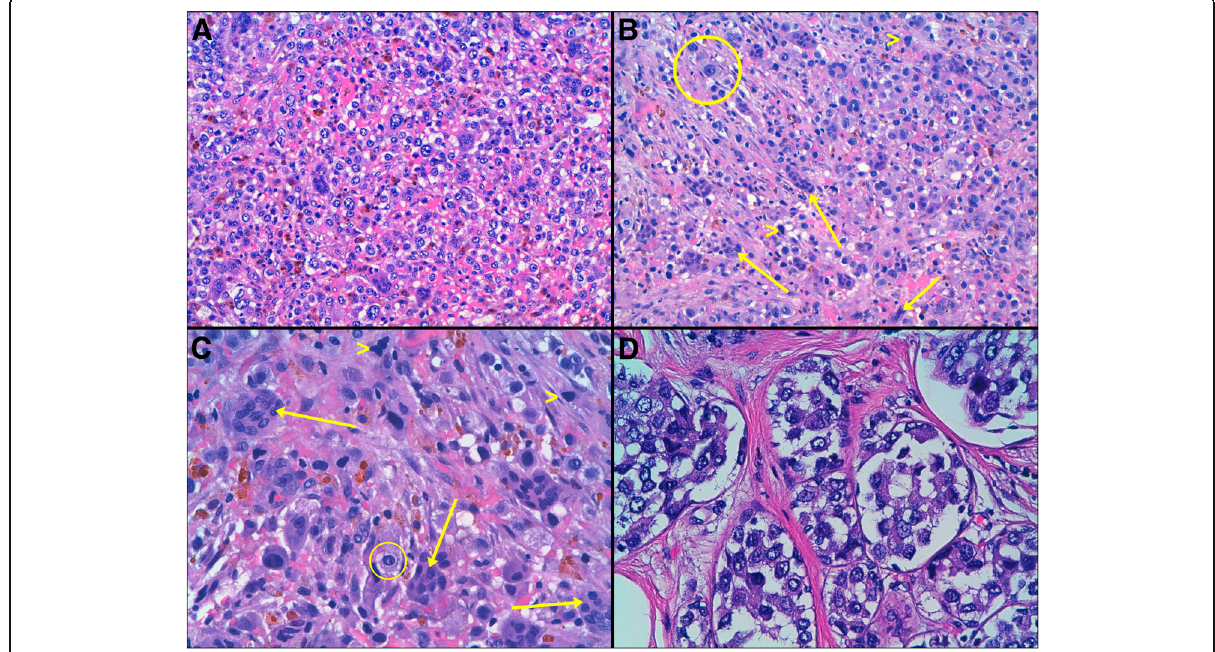
Fig. 1 Histological findings (H-E). a 20× magnification, Heterogeneous proliferation of cells in a highly vascular stroma with hemorrhagic areas, hemosiderin-laden macrophages and chronic inflammatory infiltration. b 20× magnification and c 40× magnification. Numerous osteoclast-like giant cells that vary in shape and size with an eosinophilic cytoplasm (arrows).Marked nuclear atypia: Vesicular appereance, hyperchromatic (head of arrow) or with prominent nucleolus (circle). d 40× magnification, Focus of carcinoma in situ with the same nuclear